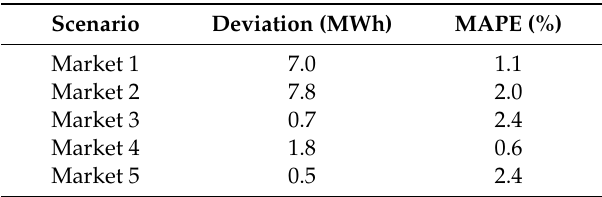
Table 4. Performance of the models in the forecasting energy